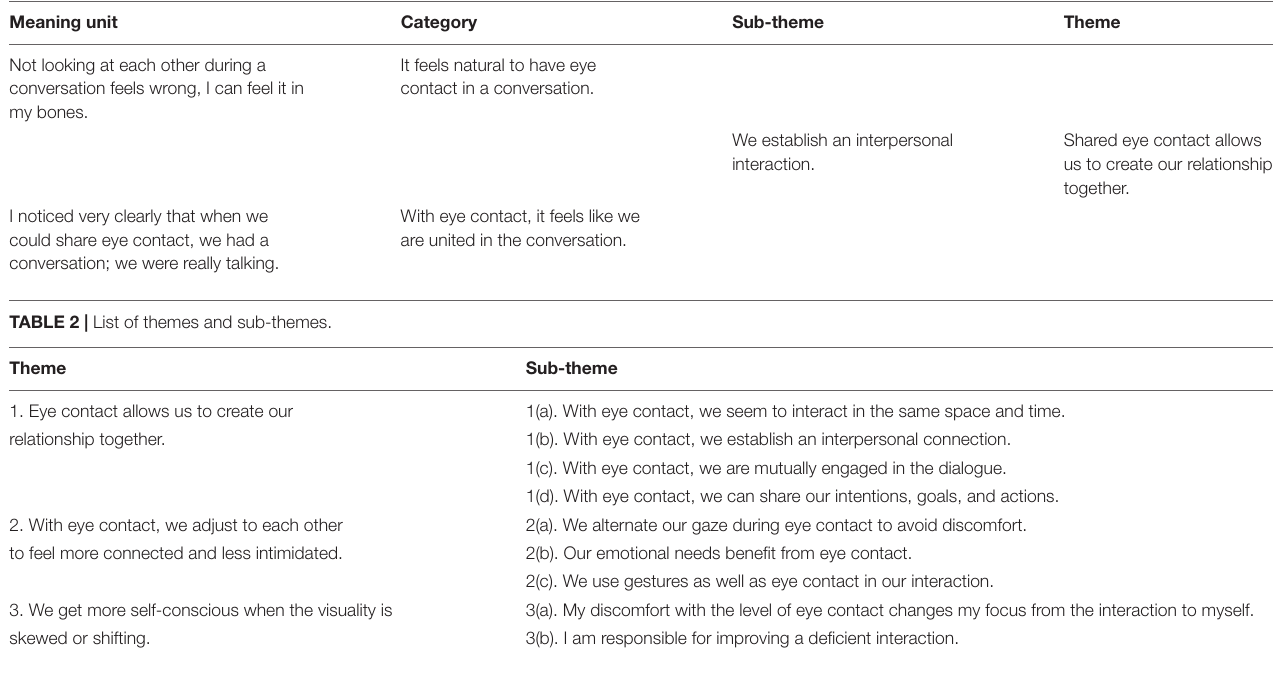
TABLE 1 | Example of the data analysis. Meaning unit